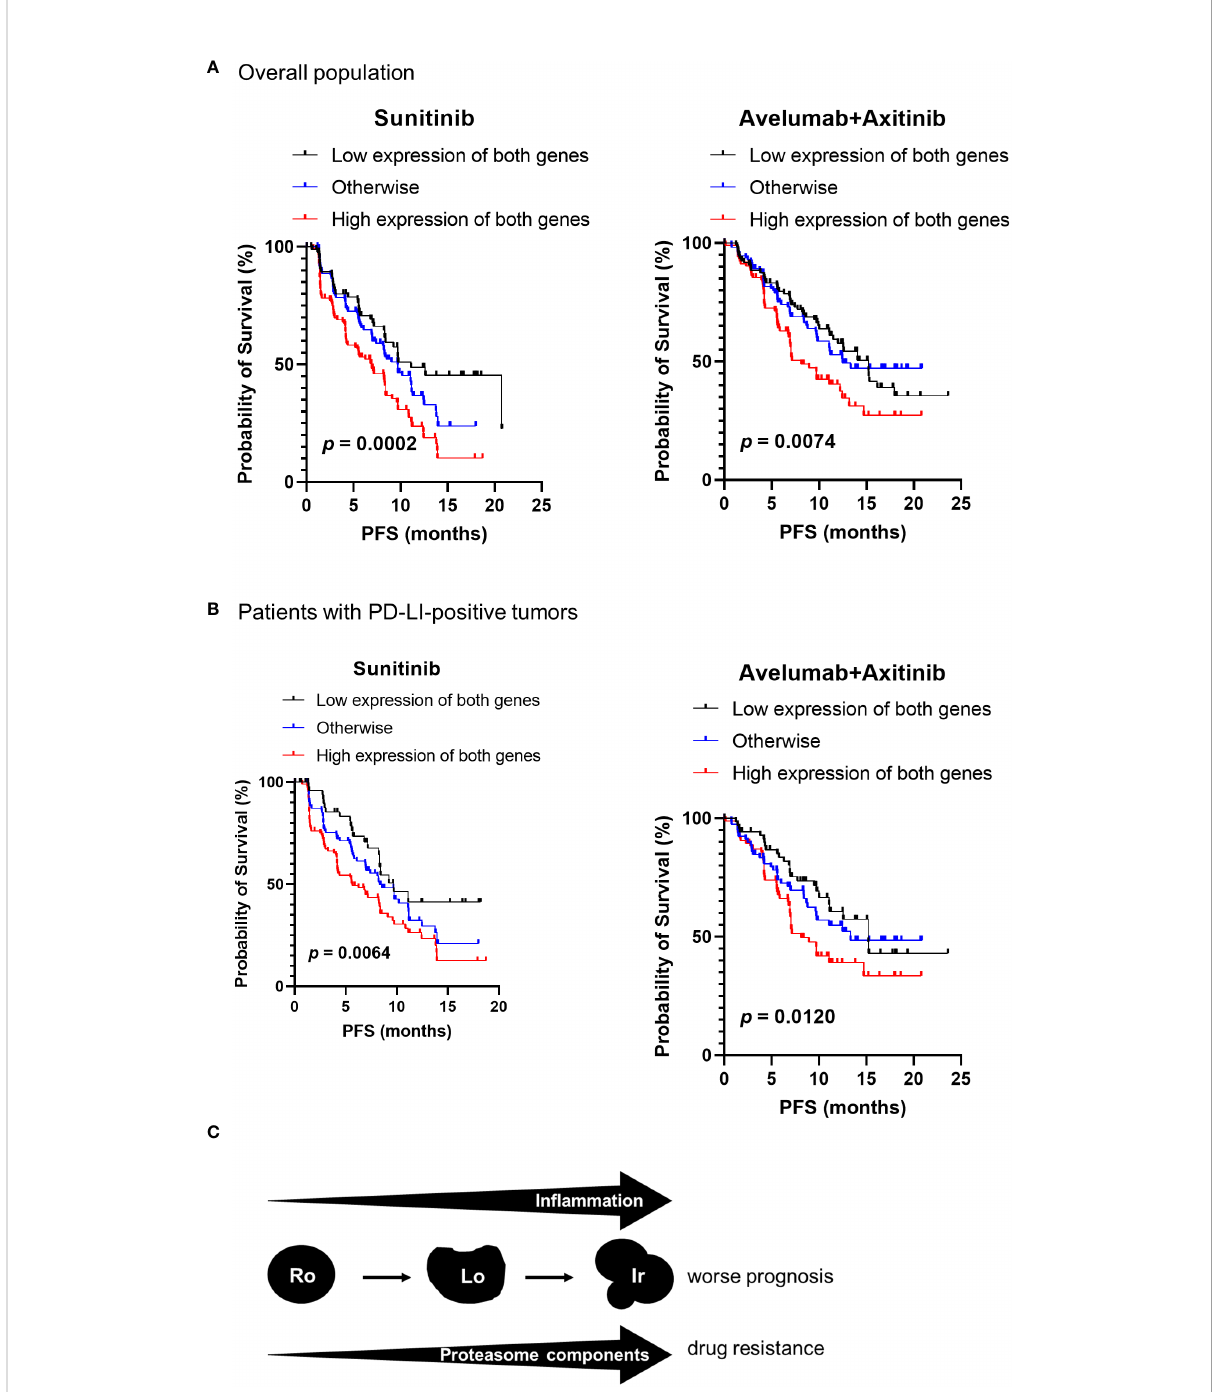
FIGURE 6 Proteasome components and drug sensitivity in advanced ccRCC. Clinical and genomic data from JAVELIN RENAL 101 phase 3 clinical trial were used. The patients were classi fi ed into three groups based on the median expression levels of PSMB1 and PSMB3 as “ low expression of both genes ” , “ high expression of both genes ” , and “ otherwise ” groups. (A) The “ high expression of both genes ” group showed signi fi cantly worse progression-free survival (PFS) in patients treated with sunitinib and with avelumab plus axitinib. (B) Similar results were obtained on comparing PFS in each group when restricted to patients with PDL1-positive tumors. (C) Schematic image of our results in this